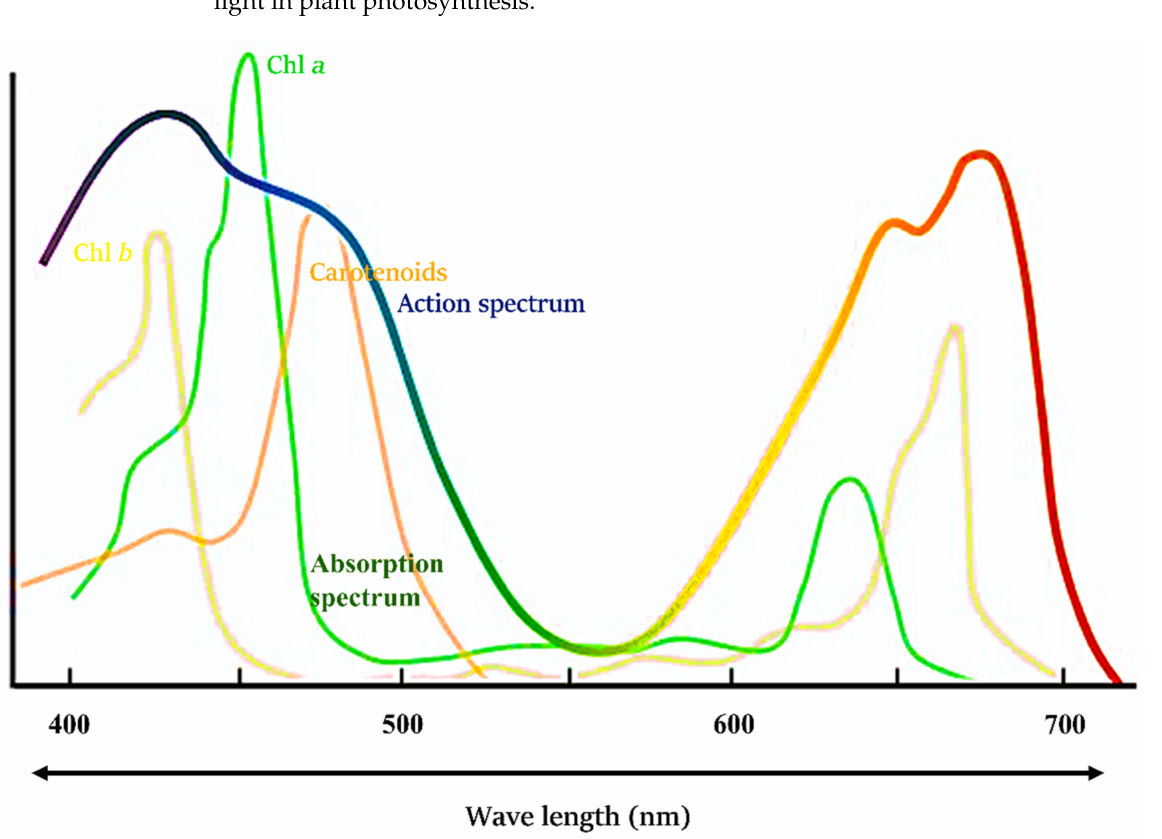
Figure 2. Absorption and action spectra of light in